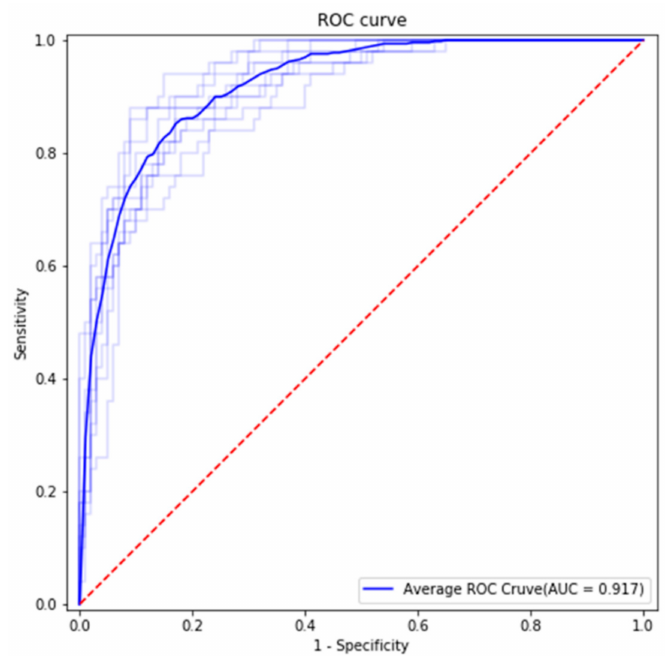
Figure 5. Classification results. The ROC curve was created by plotting sensitivity against (1-specificity) at various threshold settings. AUC is area under the curve. The blue line is the average ROC curve. The light blue lines are the ROC curves of each classification